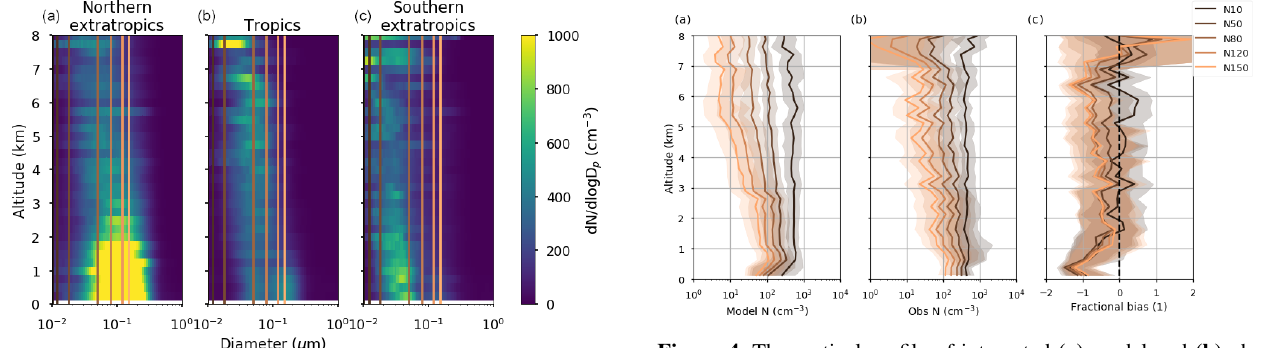
Figure 3. The median aerosol number size distribution observed at each altitude across all flights in the northern extratropics (a) , trop- ics (b) and southern extratropics (c) . The copper lines represent the sizes from which the integrated numbers in, e.g. Fig. 4 are calcu- lated.